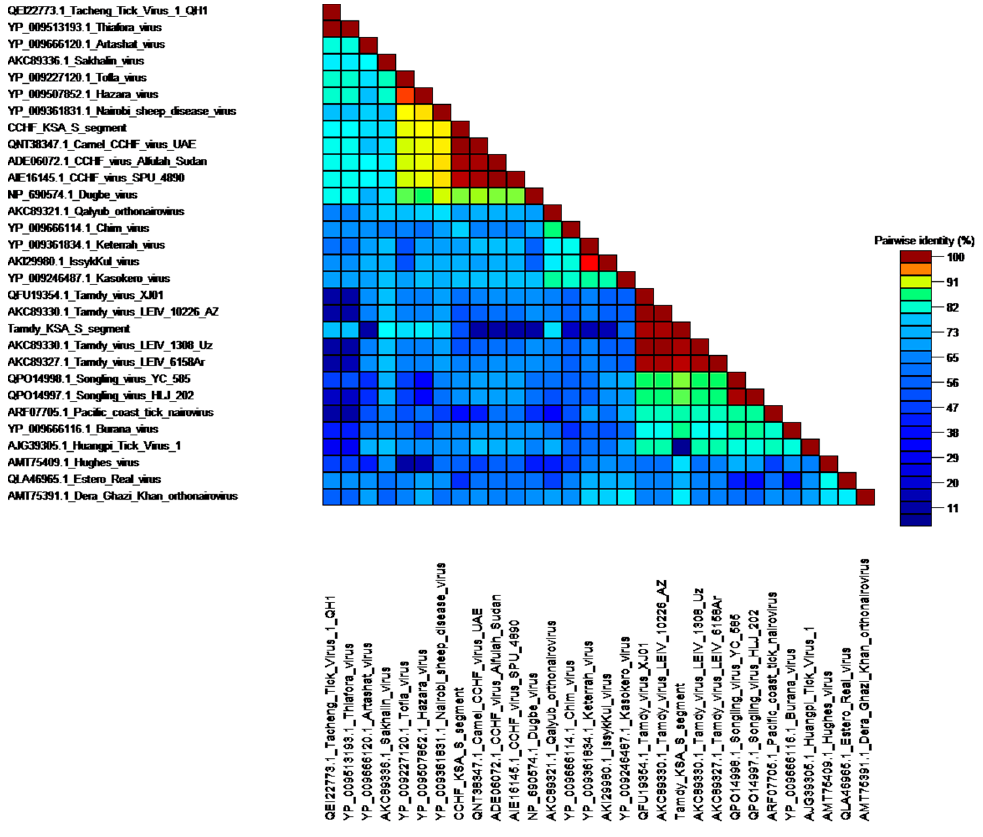
Figure 2. Pairwise protein identity matrix of nairoviruses including new strains identified in Saudi Arabia.